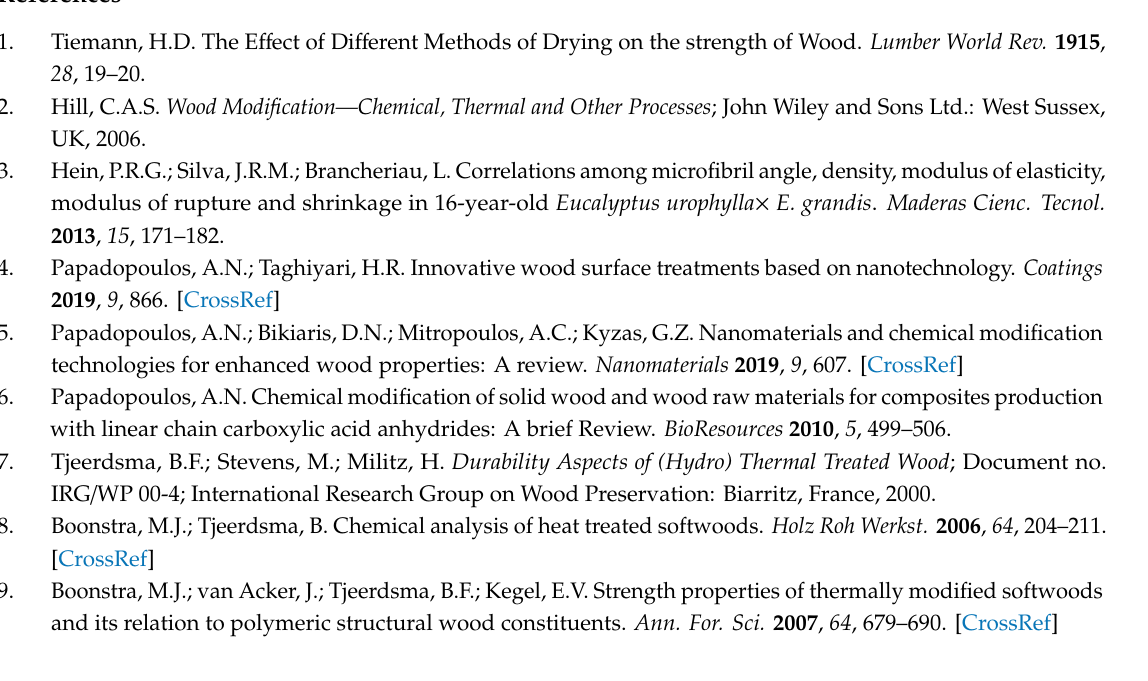
Figure S1. Contour and surface plots among mechanical properties (impact bending and compression parallel to grain) versus ATR-crystallinity., Figure S2. Contour and surface plots among physical properties (VS after 2 and 24 h immersion in distilled water) versus ATR-crystallinity (VS = volumetric